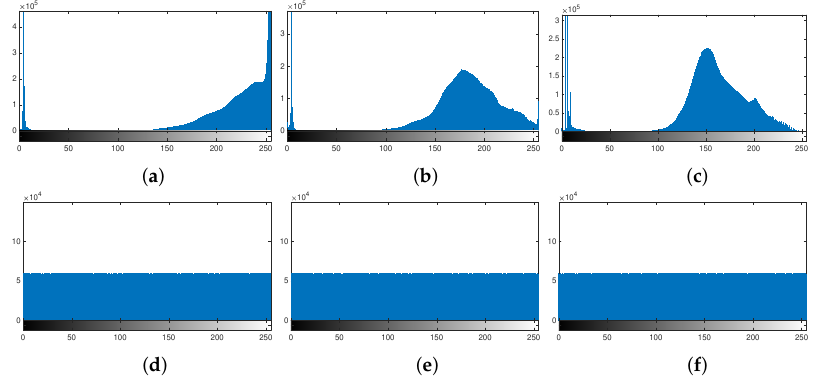
Figure 14. Histograms of image number 6 (healthy patient). ( a ) Original image, red channel. ( b ) Original image, green channel. ( c ) Original image, blue channel. ( d ) Encrypted image, red channel. ( e ) Encrypted image, green channel. ( f ) Encrypted image, blue channel.